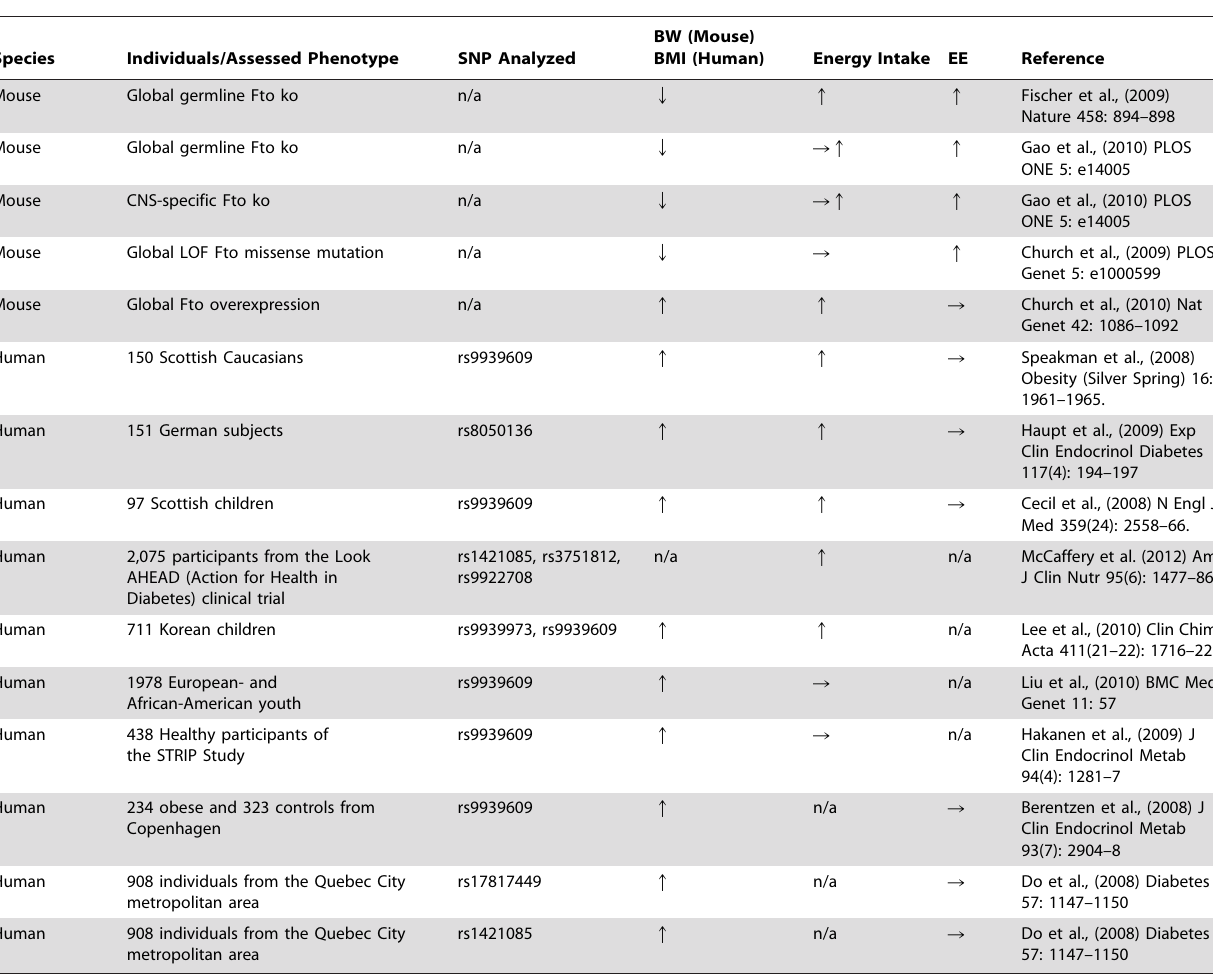
Table 1. Overview about the most relevant Fto studies analyzing food intake and energy expenditure in mice and humans.